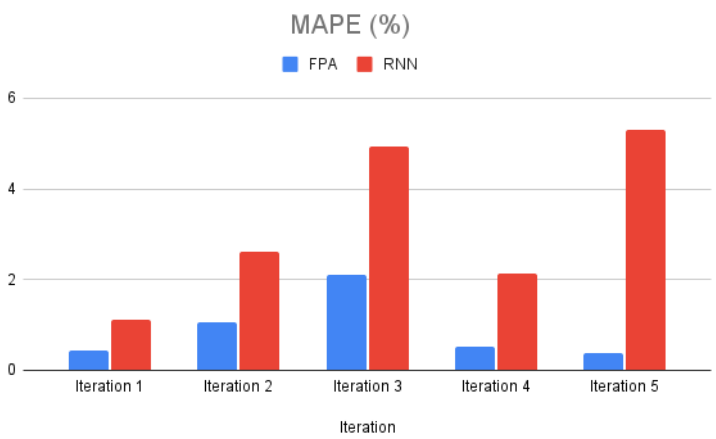
Figure 3. Bar chart of RMSE for long-term forecasting in testing data.